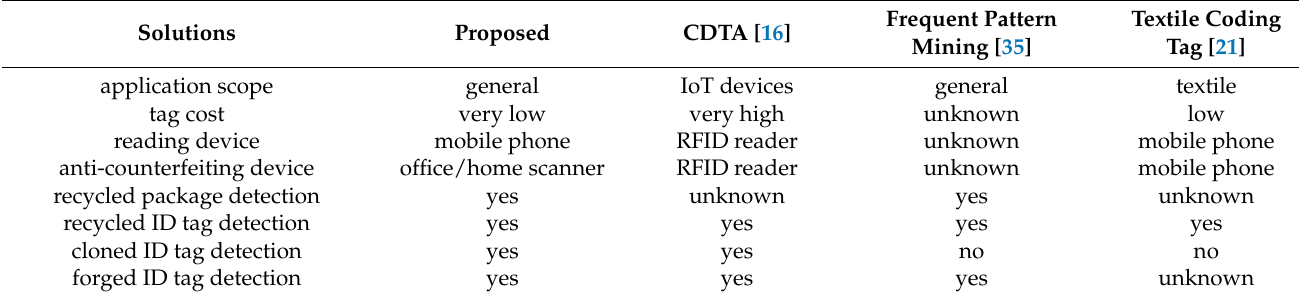
Table 3. Comparison of the proposed architecture with other anti-counterfeiting